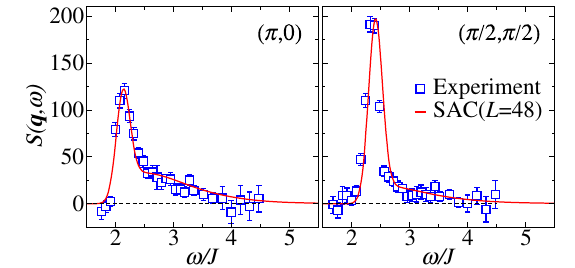
FIG. 8. Comparison of the CFTD experimental data [33] (the full scatteringcrosssectioncorrespondingtounpolarizedneutrons)and